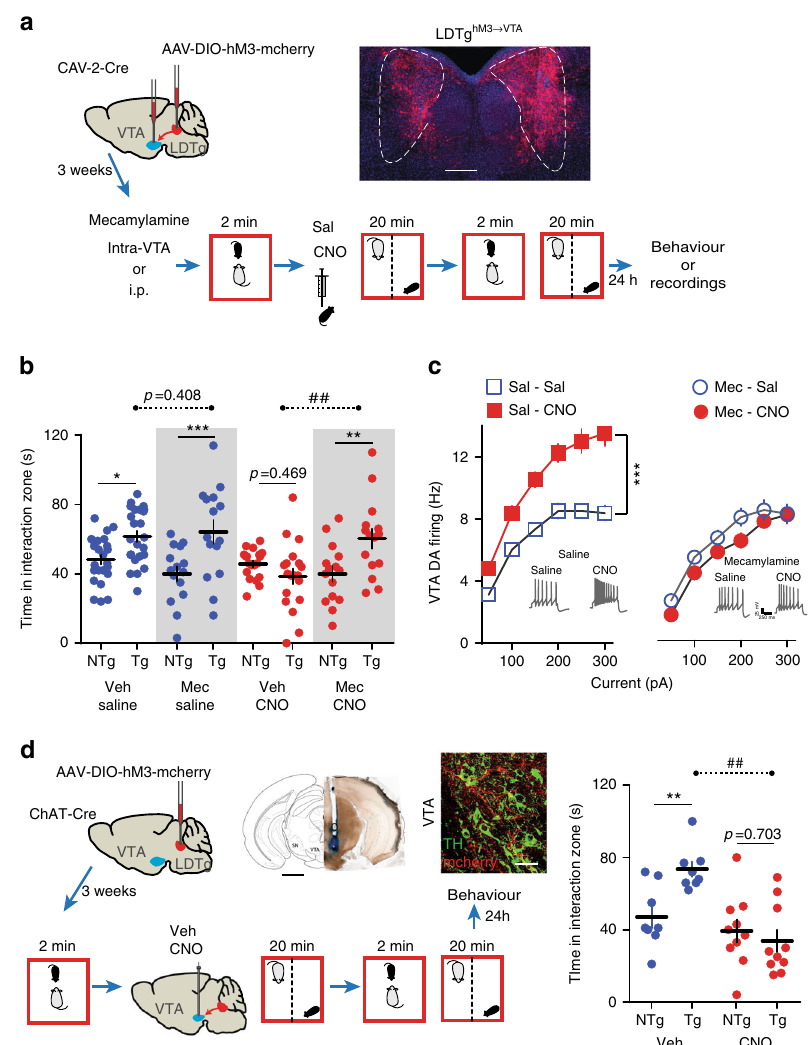
Fig. 4 LDTg cholinergic inputs to the VTA promote depressive-like maladaptations. a Bilateral stereotaxic injection of a retrograde CAV-2-Cre in the VTA combined with a bilateral injection of an AAV8-hSyn-DIO-hM3-mcherry in the LDTg of wild-type mice (LDTg hM3 → VTA ). Representative image depicting hM3-mCherry expression in LDTg neurons projecting to the VTA and schematic experimental time line. Mice were implanted with cannula guides over the VTA, allowing for local infusion. b A subthreshold defeat (SubSD) exposure combined with CNO-induced activation of LDTg neurons projecting to the VTA elicits social aversion. Mecamylamine (Mec; 1 μ g/site) infusion in the VTA before SubSD is suf fi cient to prevent this effect (number of mice: Vehicle/Sal = 24; Mec/Sal = 15; Vehicle/CNO = 19; Mec/CNO = 15). Interaction treatment × target F(3,69) = 7.69, P = 0.0002; Interaction treatment × stress F(1,69) = 0.1564, P = 0.2156; repeated-measures two-way ANOVA followed by Sidak ’ s comparisons test, asterisks depict NTg vs. Tg comparisons, hash depicts comparisons between saline vs. CNO in the Tg condition; * P < 0.05, ** P < 0.01, *** P < 0.001, ## P < 0.01. c A different cohort of LDTg hM3 → VTA mice received either systemic saline or mecamylamine (1 mg/kg) before being submitted to SubSD. CNO-induced activation of LDTg neurons projecting to the VTA combined with SubSD produced hyperactivity of VTA DA neurons. This effect was fully prevented by mecamylamine. Number of cell/mice: Sal/Sal = 18/4; Sal/CNO = 18/5; Mec/Sal = 12/4; Mec/CNO = 16/5. Interaction treatment × current F(18,360) = 6.58, P = 0.0001; repeated-measures two-way ANOVA followed by Sidak ’ s comparisons test *** P < 0.001. Representative voltage traces from each experimental condition are shown. d ChAT-Cre mice were injected with an AAV8-hSyn-DIO-hM3-mcherry in the LDTg and guides were implanted bilaterally over the VTA. Representative image shows cannula placement, scale bar = 1.2 mm. Confocal image showing cholinergic fi bers expressing mcherry in close interaction with TH-positive VTA dopamine neurons. Scale bar = 30 µ m. Local VTA infusion of CNO combined with a SubSD resulted in strong social aversion, an effect not seen in vehicle-treated mice (number of mice per condition: Vehicle = 8; CNO = 10). Interaction F(1,16) = 8.83, P = 0.009; repeated-measures two-way ANOVA followed by Sidak ’ s comparisons test, asterisks depict NTg vs. Tg comparisons, hash depicts comparisons between saline vs. CNO in the Tg condition; ** P < 0.01, ## P < 0.01. All plots depict mean ± projections to the mesolimbic pathway not only convey reward- ing information but also promote alertness in cases of threatening situations. The LDTg is therefore a more versatile brain structure orders 4 . Most preclinical models of depression rely on exposure to stressful experiences 41 . Despite inducing shared behavioral than originally thought and should therefore be considered as a maladaptations, these models are underpinned by different, and key upstream regulator of the VTA that shapes responses to sometimes opposite, cellular changes within the DA system. salient stimuli, either rewarding or aversive.